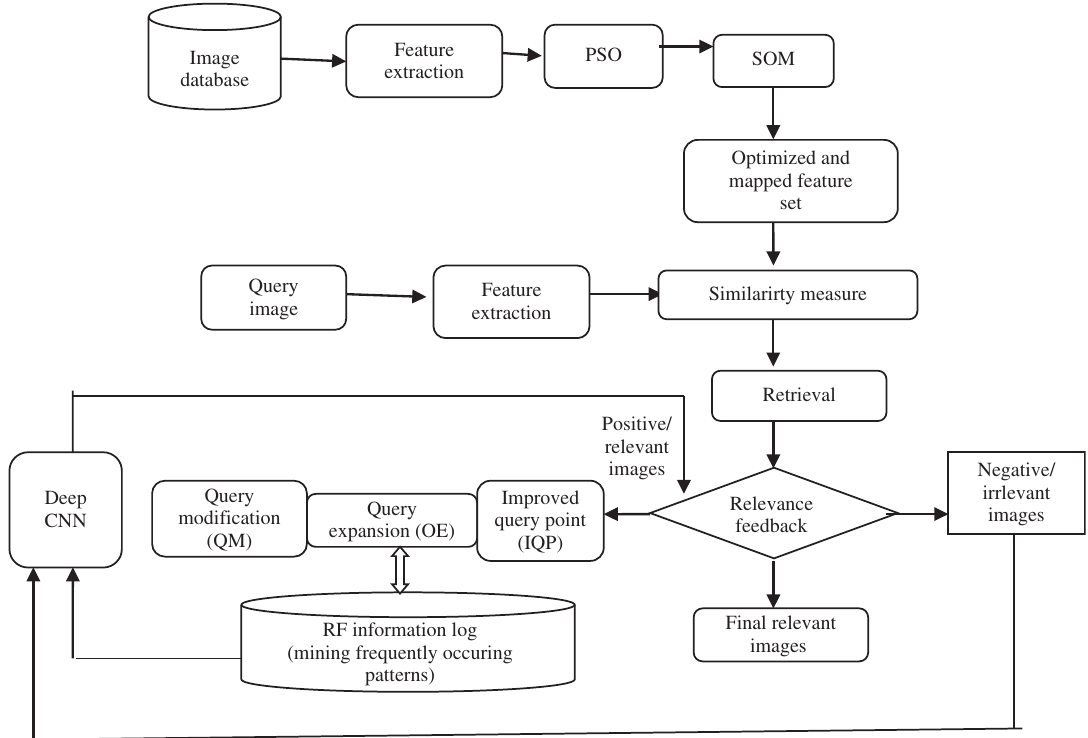
Figure 1: The Proposed